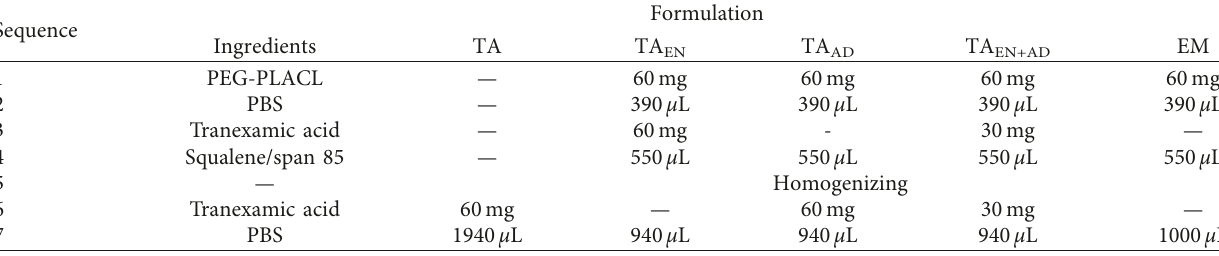
Table 1: Ingredients of emulsion formulation and preparation sequence.